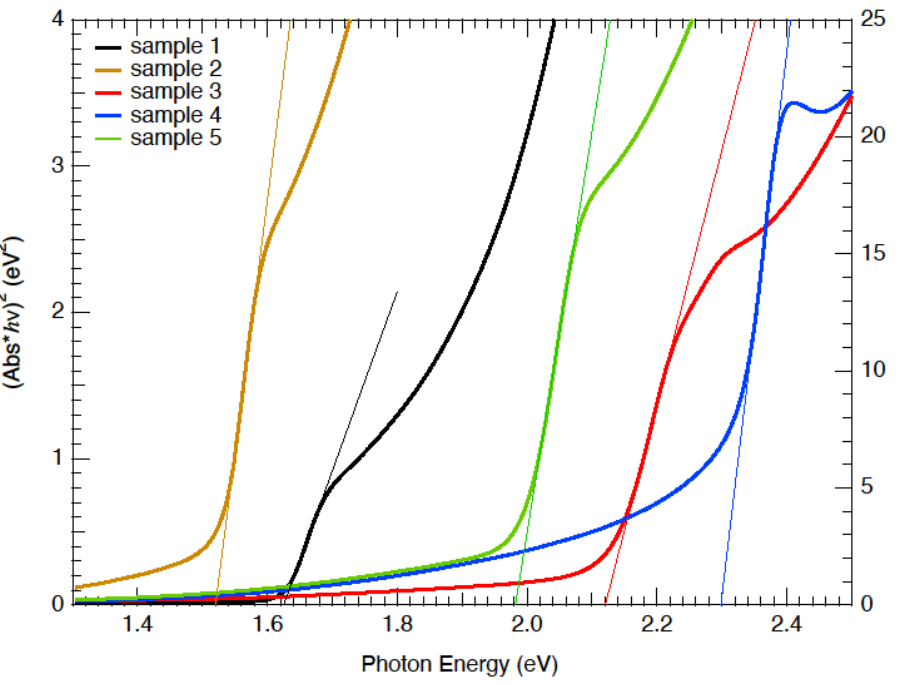
Figure 5. Tauc plots, assuming a direct bandgap, of the solar-cell devices with varying anion compositions.